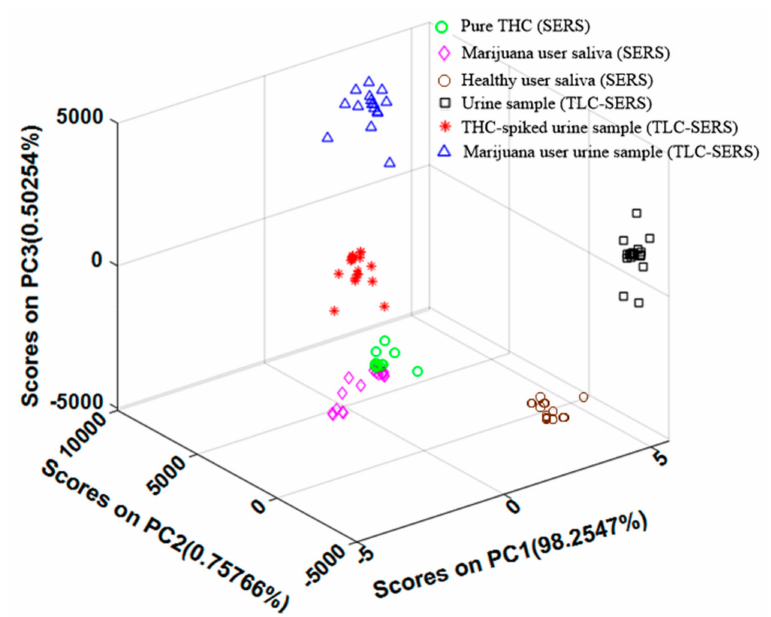
Figure 6. PCA scatter plot of SERS spectra of the first three PC score: pure THC (SERS), marijuana user saliva (SERS), healthy people saliva, urine sample (TLC-SERS), THC-spiked urine sample (TLC-SERS), and marijuana user’s urine sample